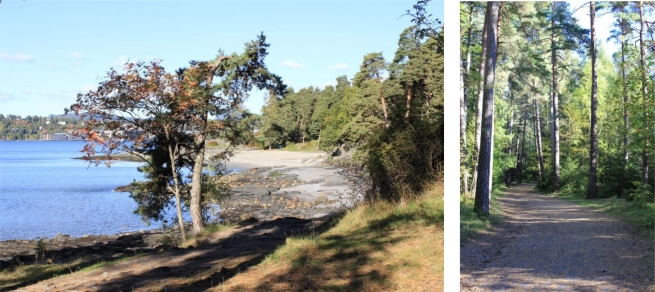
Photos from Bygdøy.